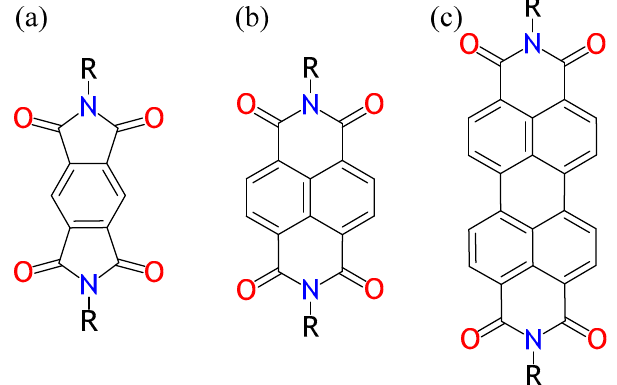
Figure 1. Chemical structures of N , N ′ -dialkylated pyromellitic diimides (PyDI, ( a )); N , N ′ -dialkylated naphthalene diimides (NDI, ( b )); and N , N ′ -dialkylated perylene diimides (PDI, ( c )). R-substituents are n-alkyl chains. For the NDIs described in this paper, the R may include from 3 through 11 carbon atoms in a linear alkyl chain.